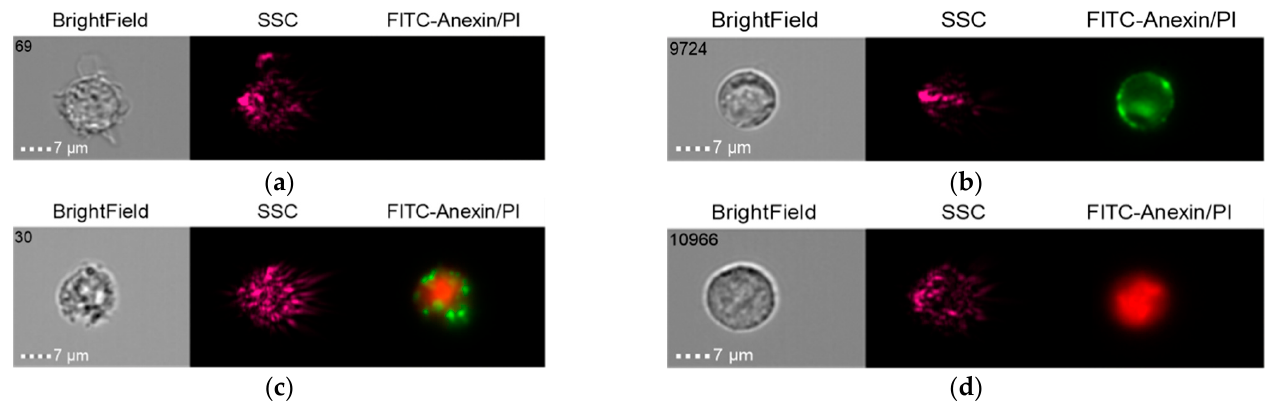
Figure 11. Live cells ( a ), early apoptosis ( b ), late apoptosis ( c ), necrosis ( d ) after co-culture of Alpha Bio NSMP with THP-1 cell line (Alpha Bio NSMP + LPS + THP-1).